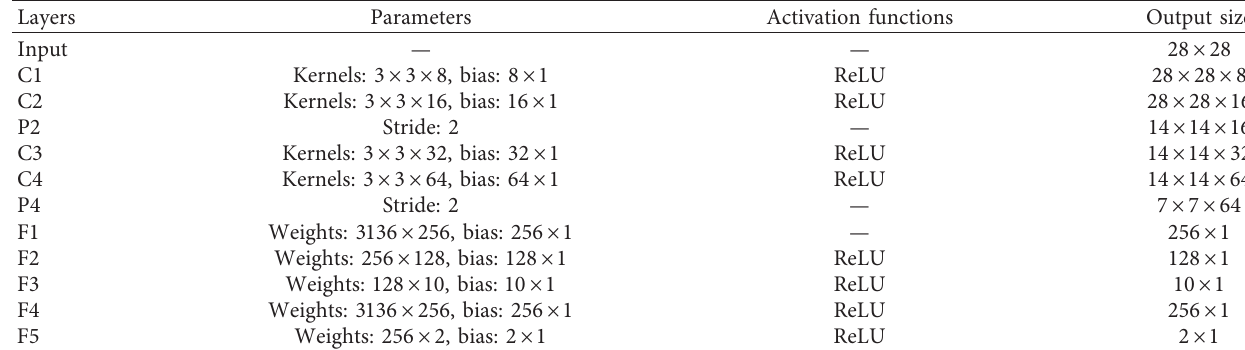
Table 2: Parameter set of the network.